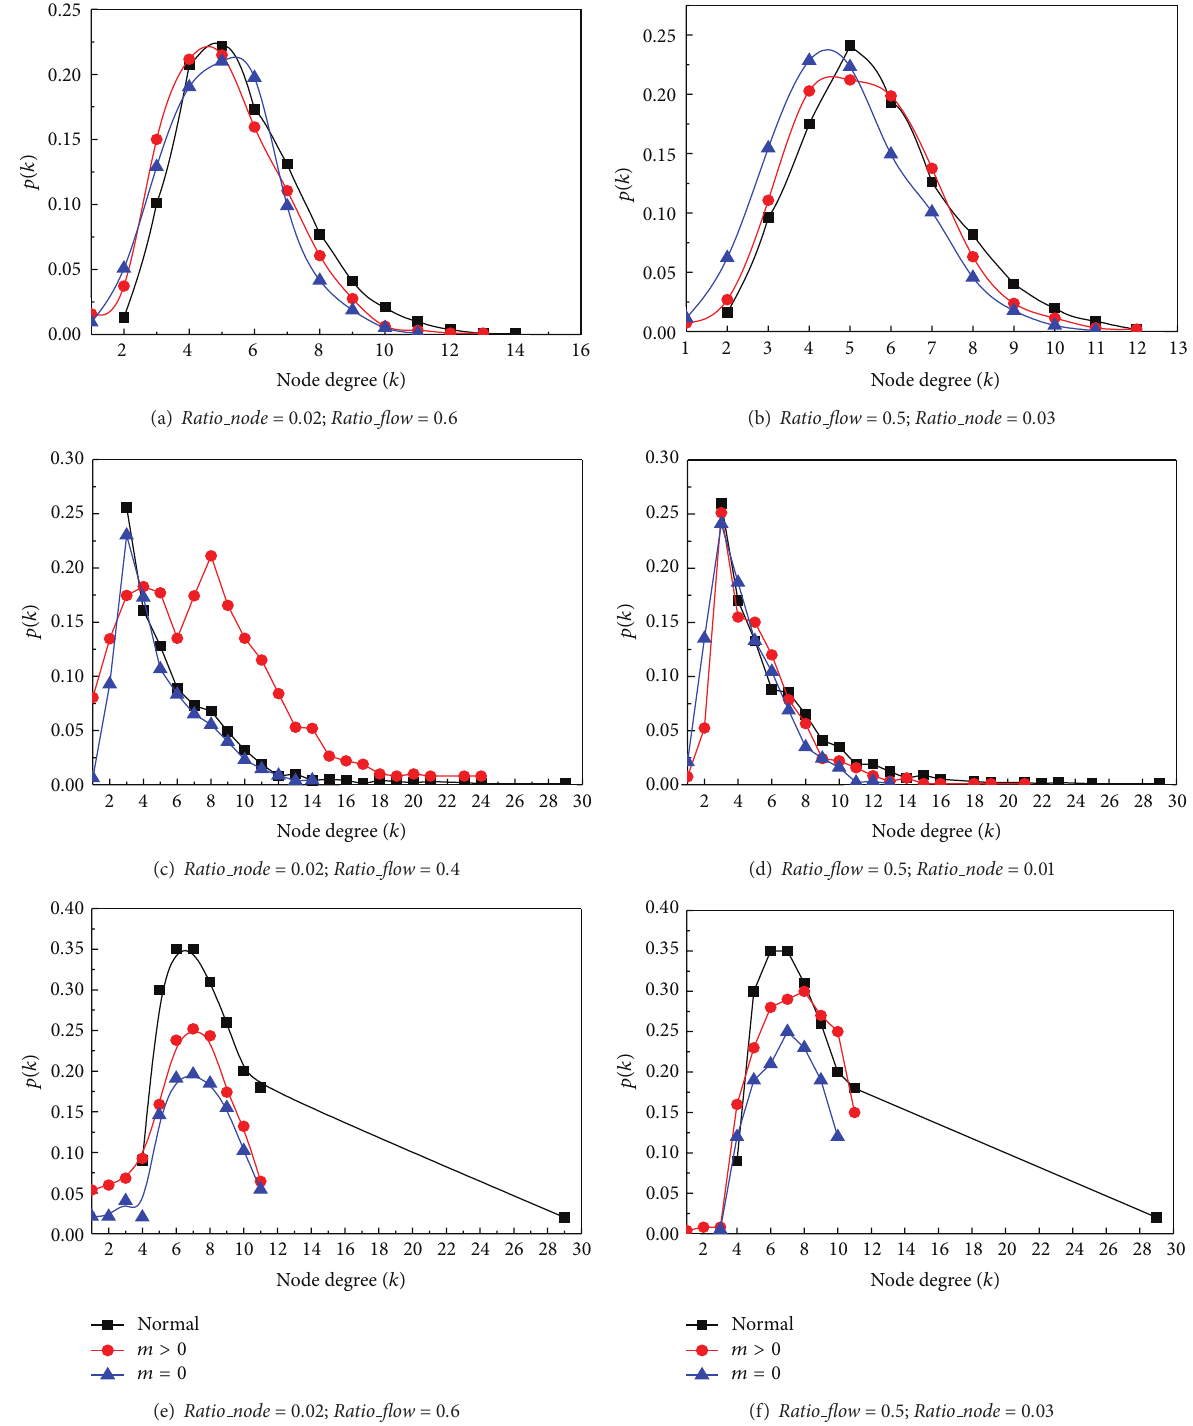
Figure 8: Network shifts from node failure recovery in different network topologies.